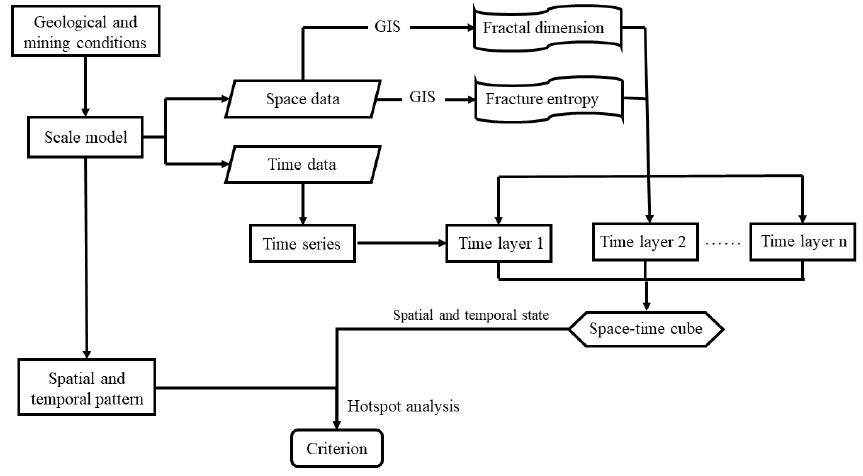
Figure 2. Flow chart of spatial and temporal visualization analysis.